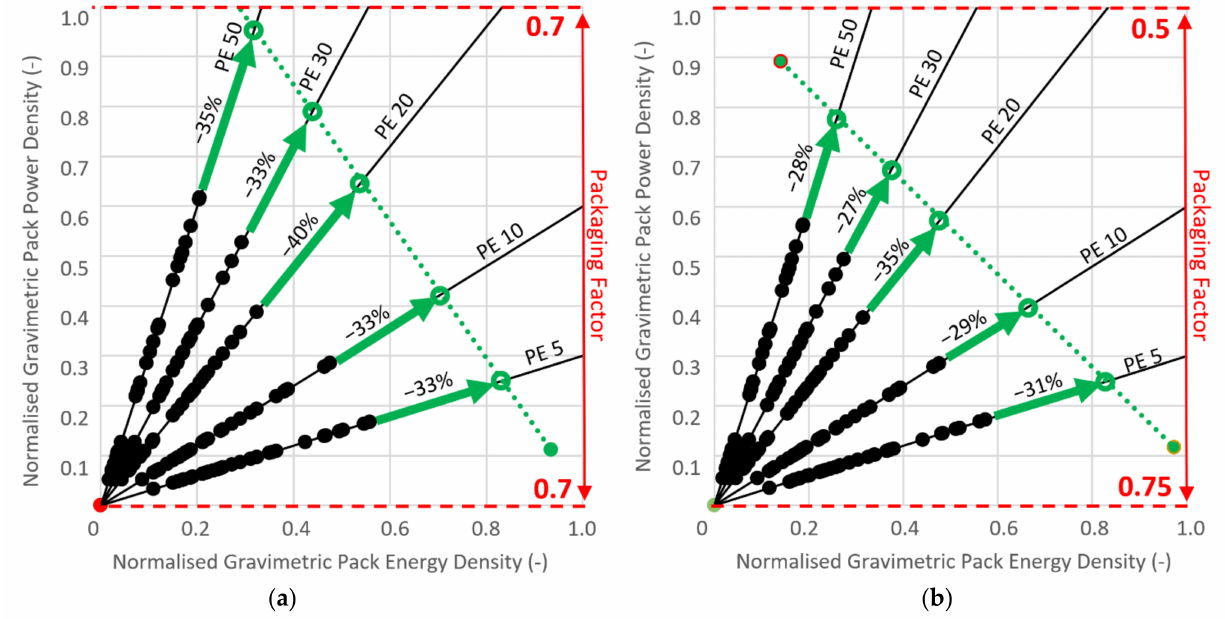
Figure 14. Ragone plot of the ‘actual’ weight-saving HESS analysis method considering ( a ) a uniform packaging density of 70% across the Ragone plot and ( b ) packaging density varying linearly from 75% at 0 kW/kg to 50% at 10